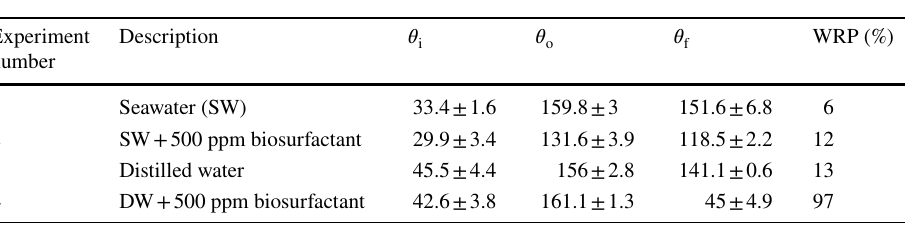
Table 2 Contact angle data of surfactin effect on calcite slices